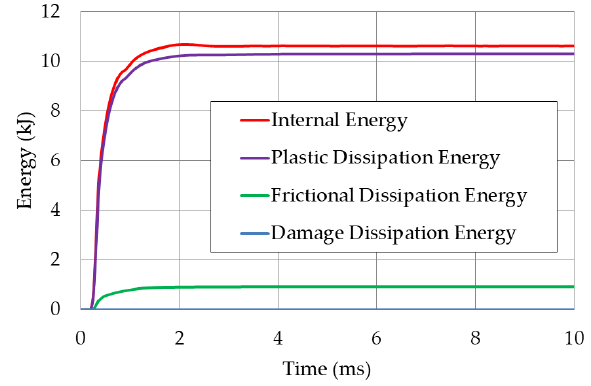
Figure 16. Energy components of the graded trapezoidal core, when subjected to 0.5 kg of TNT at R = 0.5 m (BI-5).